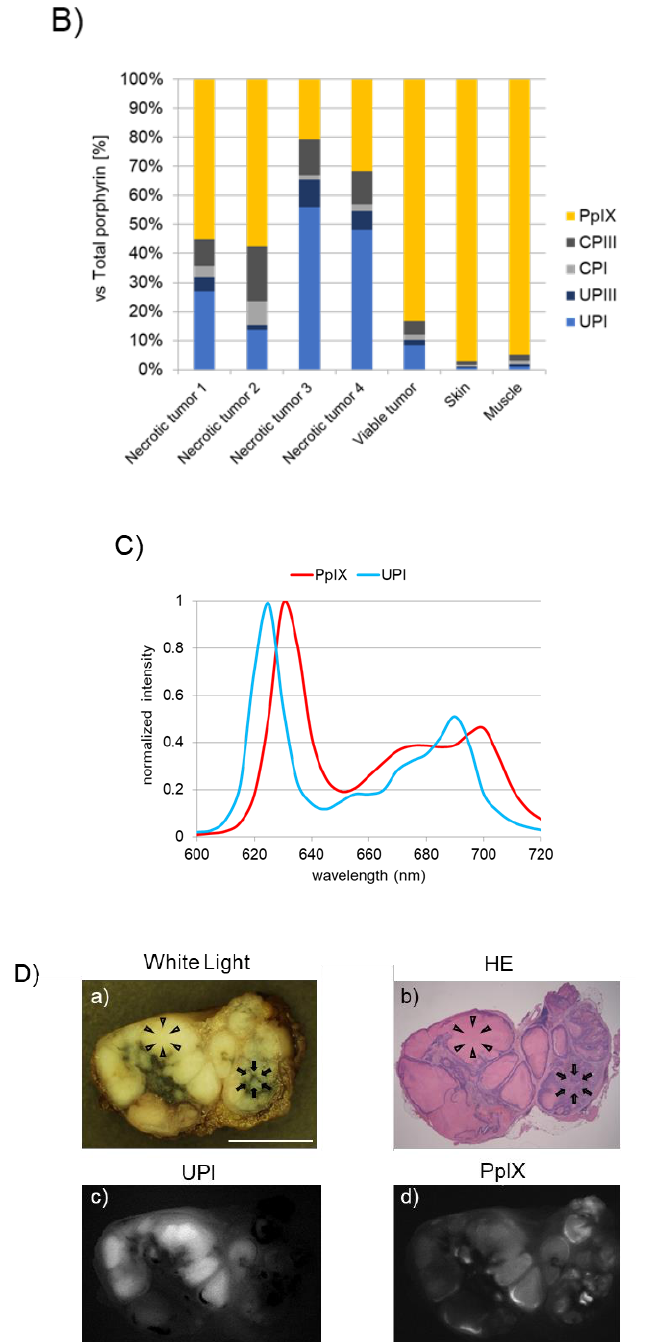
Figure 3. Accumulation of uroporphyrin I (UPI) in necrotic tumor tissues after administration of 5-aminolevulinic acid (5-ALA). “Reprinted/adapted with permission from Ref. [17]. 2021, MDPI”. ( A ) Metabolic pathways of 5-ALA in viable and necrotic tumor tissues. Black and gray arrows represent mainstream and non-mainstream routes, respectively. UPI, UPIII, CPI, and CPIII are produced from corresponding porphyrinogens via autooxidation and/or photocatalysis. PBG, porphobilinogen; PBGD, porphobilinogen deaminase; HMB, hydroxymethylbilane; UROS, uroporphyrinogen III syn- thase; UPGIII, uroporphyrinogen III; CPGIII, coproporphyrinogen III; PpIX, protoporphyrin IX; UPIII, uroporphyrin III; CPIII, coproporphyrin III; PPp, photo-protoporphyrin; UPGI, uroporphyrinogen I; CPGI, coproporphyrinogen I; CPI, coproporphyrin I. ( B ) High-performance liquid